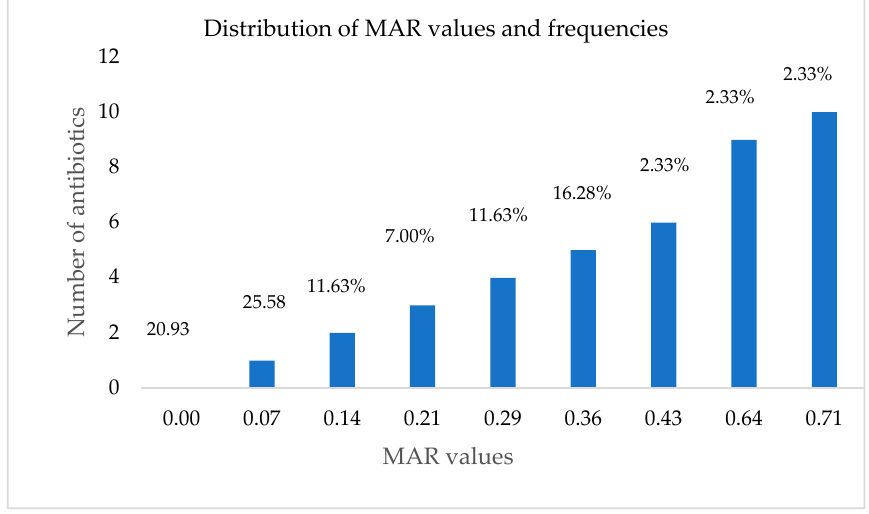
Figure 3. Frequency of Listeria isolates exhibiting resistance against the tested antibiotics (TS, co- trimoxazole; E, erythromycin; CIP, ciprofloxacin; C, chloramphenicol; TET, tetracycline, SMX, sul- famethoxazole, AUG, augmentin; S, streptomycin; CTX, cefotaxime, GEN, gentamicin; AMP, ampi- cillin; AML, amoxicillin; NA, nalidixic acid; NI, nitrofurantoin). The data in Figure 3 (only for resistance) was employed to determine the index of multiple antibiotic resistance (MAR) for each bacterial strain. MAR values ranged from 0 to 0.71. MAR value > 0.2 denote multidrug resistance and includes bacterial isolates demonstrating resistance to three or more antibiotic classes. In this study, the number of Listeria species with MAR values > 0.2, was 18 of 43, i.e., a prevalence rate of 41.86%, as seen in Figure 4.